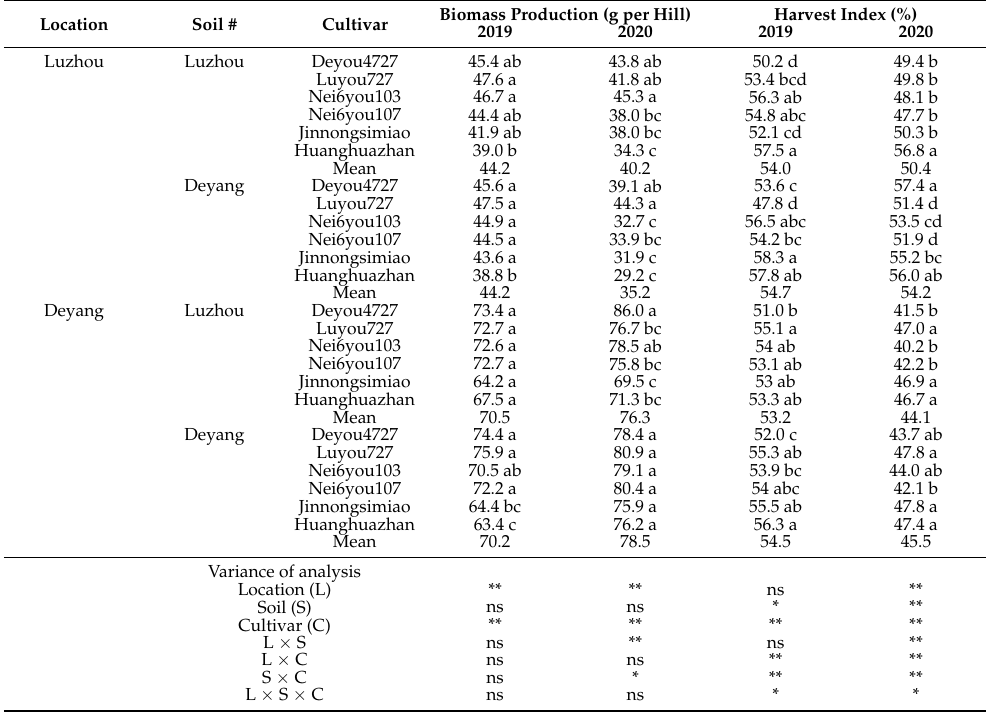
Table 8. Biomass production and harvest index of six rice cultivars grown under two different ecological conditions in a pot experiment from 2019 to